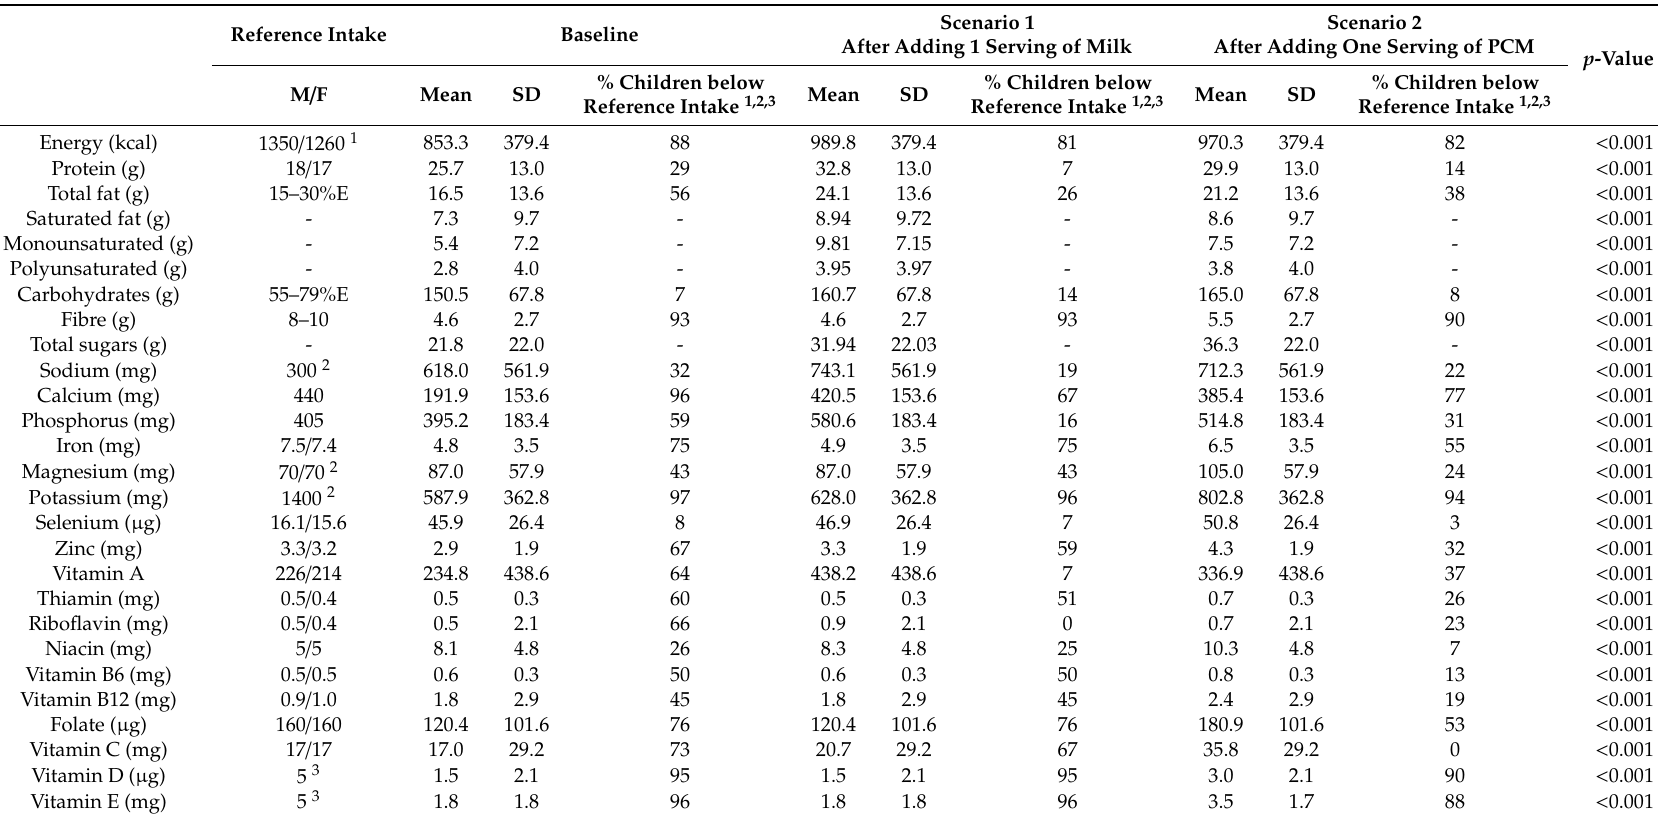
Table 3. Mean nutrient intakes and inadequacy at baseline and after modelling scenarios 1 and 2, in children aged three to four years ( n =